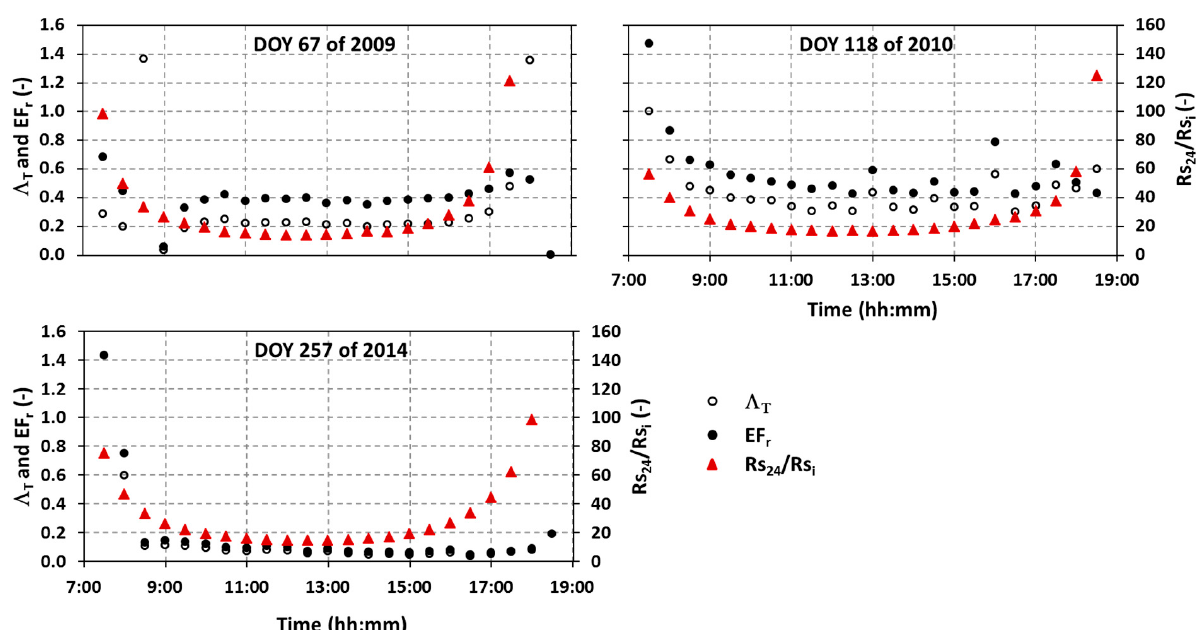
Figure 4. Daytime temporal variability of 30 min scaled evaporative fraction ( Λ T ), reference evaporative fraction (EF r ) and incoming shortwave radiation flux ratio ( Rs 24 /Rs i ) during DOY 67-2009, 118-2010 and 257-2014.